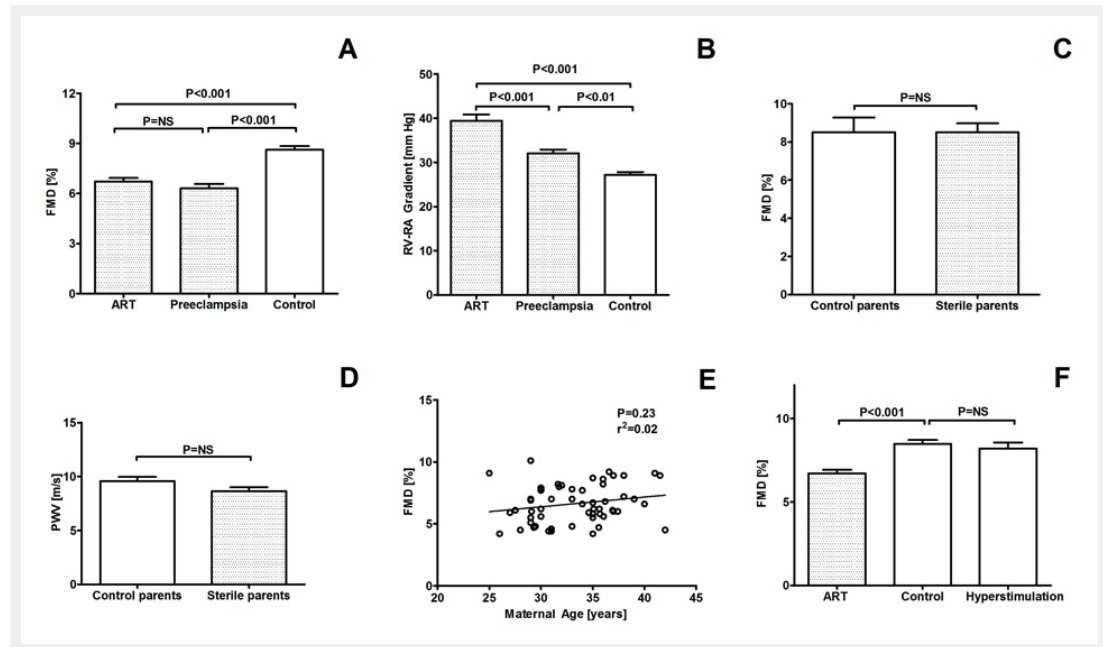
Figure 3 Flow-mediated vasodilation (FMD) of the brachial artery and right ventricular to right atrial (RV-RA) pressure gradient in children conceived by assisted reproductive technologies (ART), in offspring of mothers suffering from preeclampsia and in age- and gender-matched healthy control children (Panel A and B). FMD and pulse wave velocity (PWV) in fertile parents of control children and of sterile parents ART children (Panel C and D). Relationship between maternal age and FMD in ART children (Panel E). FMD in control children, ART children and children naturally conceived during stimulation of the ovulation in the mother (Panel F). Data are expressed as mean ± SEM. ANOVA and Bonferroni post-doc test (for Panel A, B and